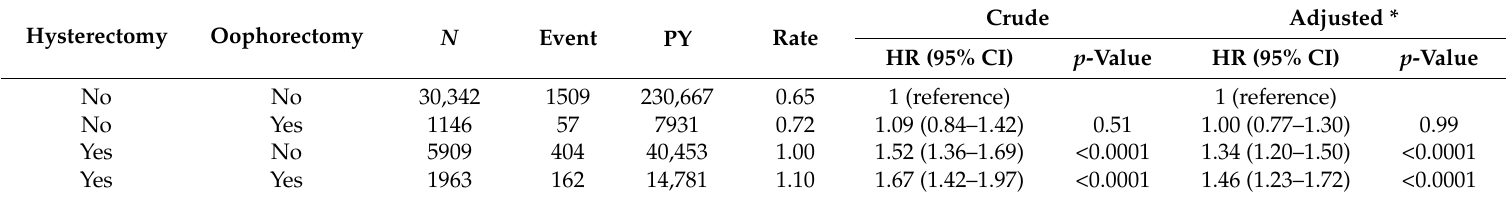
Table 3. Risk of depression in women underwent hysterectomy or